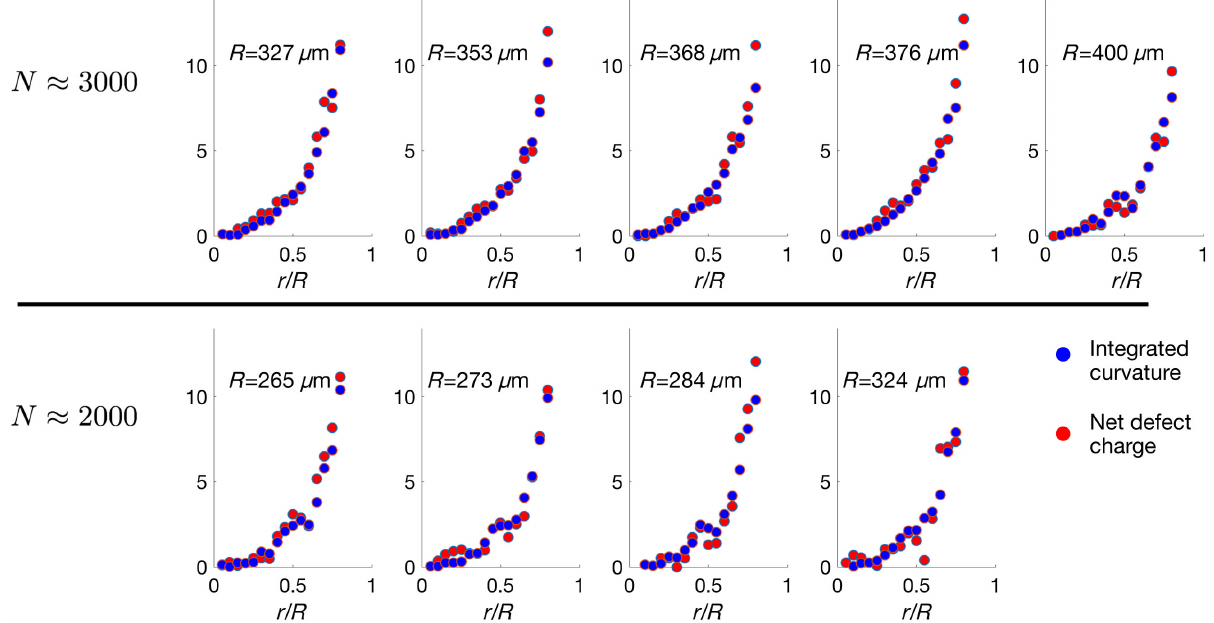
FIG. 9. Experimental comparison of net disclination charge and integrated curvature distribution. The net disclination charge enclosed within varying radii is compared to the integrated curvature within that radii. The two quantities are found to be proportional at each radii. Here, each plot corresponds to a different-sized crystal, and each row of plots corresponds to a crystal with a different number of total particles, N